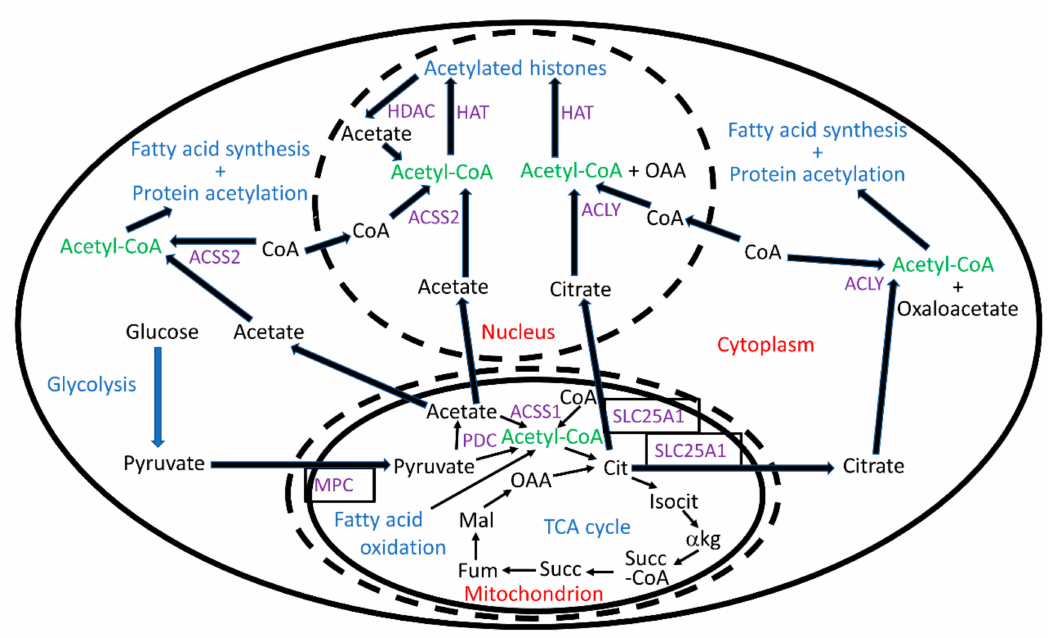
Figure 1. The substrates for the synthesis of cytoplasmic or nuclear acetyl-CoA by ACLY or ACSS2 are largely mitochondrial- synthesized citrate or acetate, respectively, although the acetate released from deacetylated nucleocytoplasmic proteins can also be an important substrate for ACSS2. Abbreviations: Cit, Citrate; Isocit, Isocitrate; α kg, Alpha-ketoglutarate; Succ-CoA. Succinyl-CoA; Succ, Succinate; Fum, Fumarate; Mal, Malate; OAA, Oxaloacetate; MPC, Mitochondrial pyruvate carrier; SLC25A1, Mitochondrial citrate carrier; PDC, Pyruvate dehydrogenase complex; ACLY, ATP-citrate lyase; ACSS1, Acetyl-CoA synthetase short-chain family member 1; ACSS2, Acetyl-CoA synthetase short-chain family member 2; and HAT, Histone acetyltransferase. Proteins are shown in purple font with membrane transporters boxed, while metabolites are shown in black font, except for acetyl-CoA in green font. Pathways are shown in blue font, while subcellular localizations are labeled in